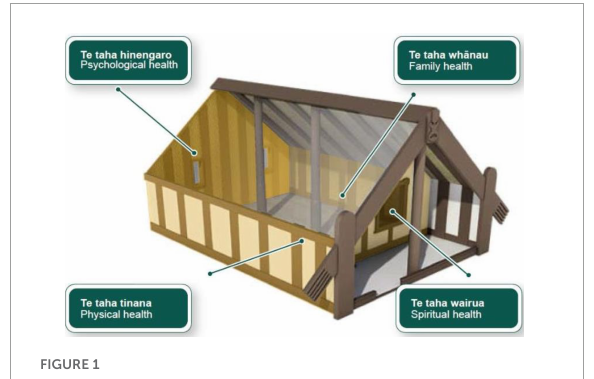
FIGURE1 Durie (1994) model of Whare Tapa Rima . Reproduced with permission.